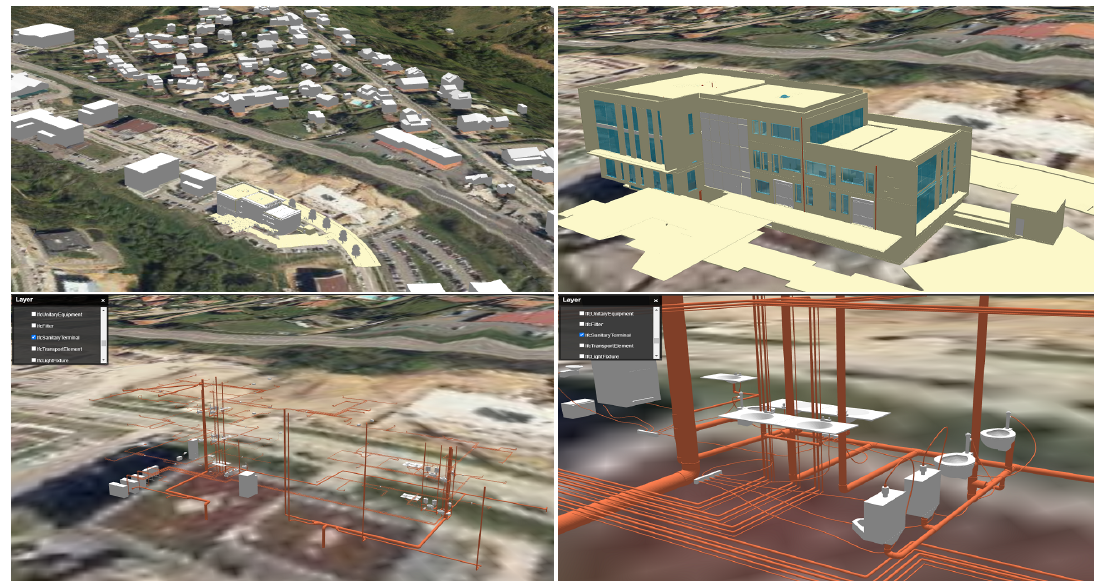
Figure 5. Contextual views of a faucet, using 3D spatial representations of CityGML (in white) and Ifc (colored) data, from a city view (top left) to an object view (bottom right)